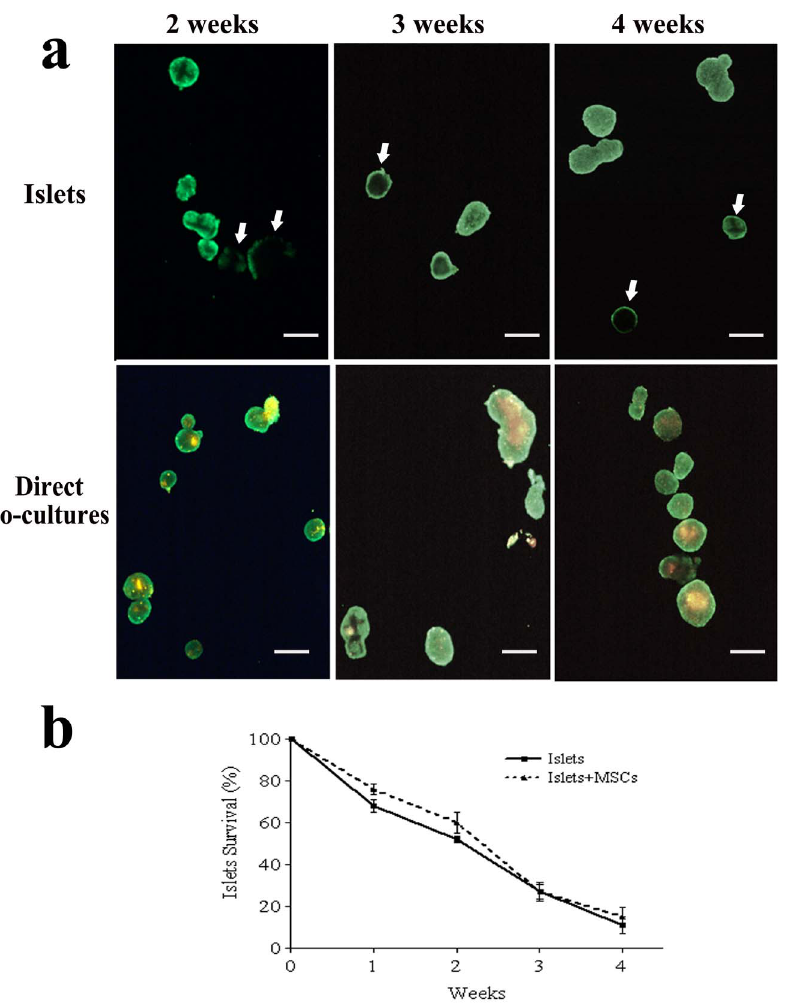
Figure 2. Viability assessment of MSC-coated pancreatic islets. The viability of pancreatic islets coated with MSCs was assessed by using the vital fluorescent dye calcein, which evidenced in green only viable cells. Upper panel: pancreatic islets cultured alone stained with calcein after 2, 3 and 4 weeks of culture. Lower panel: pancreatic islets directly co-cultured with DiI red-stained MSCs which appear as yellow spots after 2, 3 and 4 weeks of culture. Arrows indicate pancreatic islets in which calcein did not spread uniformly. Bar 150 m m. b) Percentage of pancreatic islets’ survival, expressed as mean 6 SD. Calcein-positive pancreatic islets were counted and the survival percentage was calculated up to 4 weeks of culture.